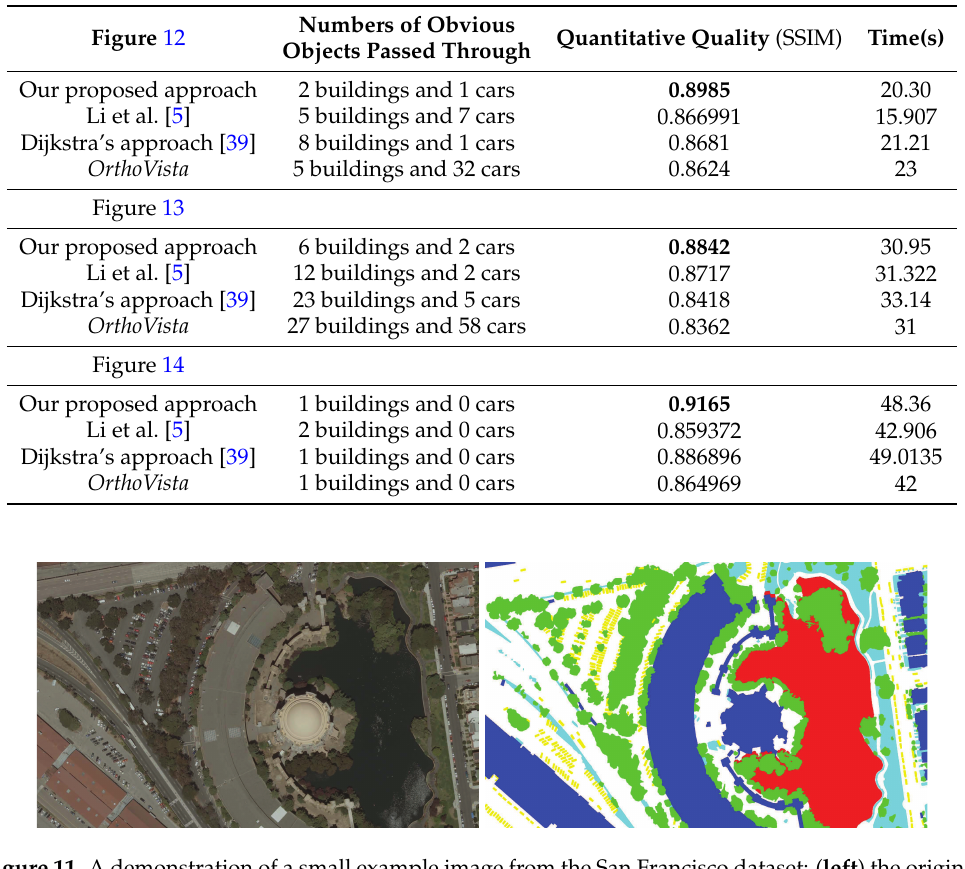
Numbers of Obvious Figure 12 Objects Passed Through